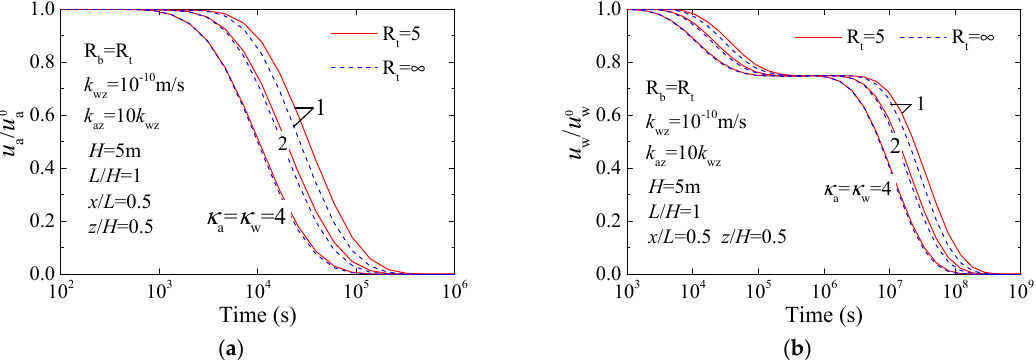
Figure 11. Variations of excess pore-pressures under vertical impeded drainage boundary with different anisotropic permeability ratios: ( a ) air phase and ( b ) water phase.